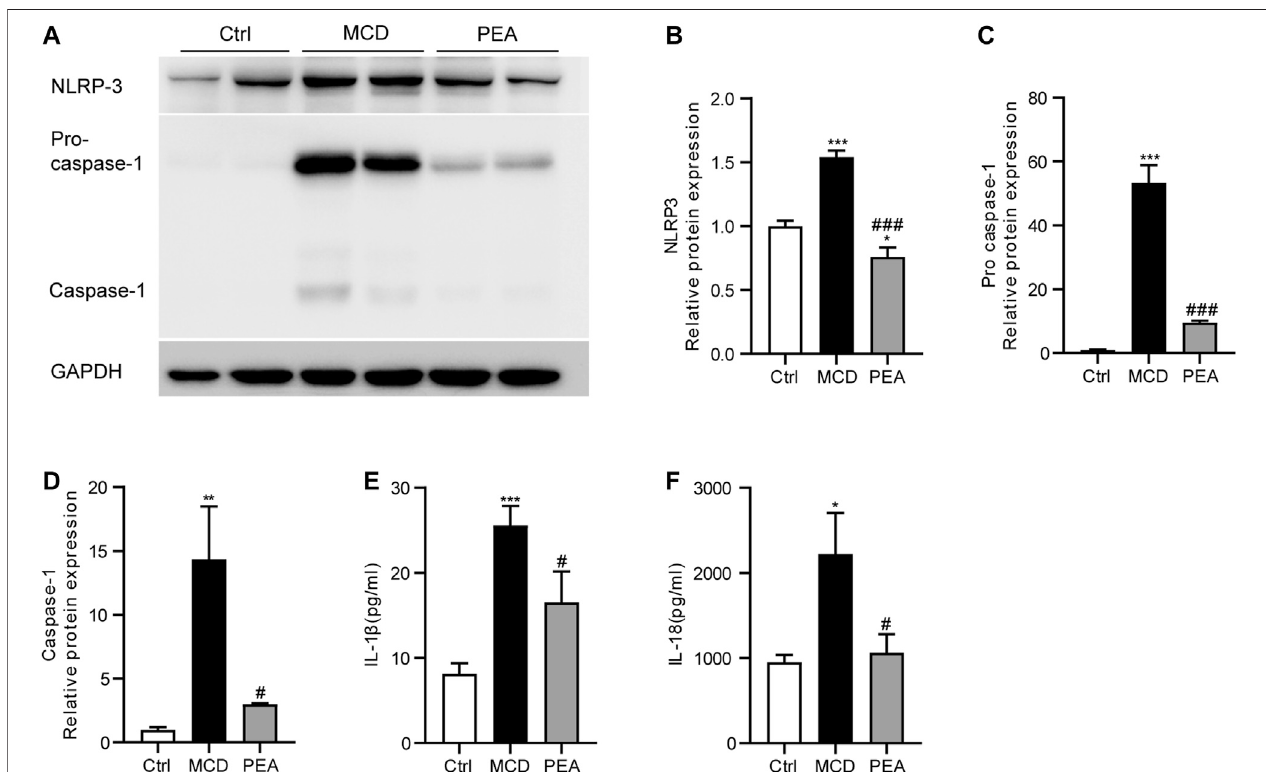
FIGURE 5 | PEA attenuated MCD-induced NLRP3 in fl ammasome activation. (A – D) Key protein levels of the NLRP3 in fl ammasome pathway were analyzed via western blotting. (E) IL-1 β and (F) IL-18 levels in plasma were measured using the ELISA method. Ctrl: the mice treated with standard diet; MCD: the mice treated with MCD diet;PEA: themice treatedwithMCD diet and PEA.Values were expressed asthemean ± SEM, n (cid:1) 6 – 8for each group. * p < 0.05, ** p < 0.01, *** p < 0.001 versus the Ctrl group; # p < 0.05, ### p < 0.001 versus the MCD group.